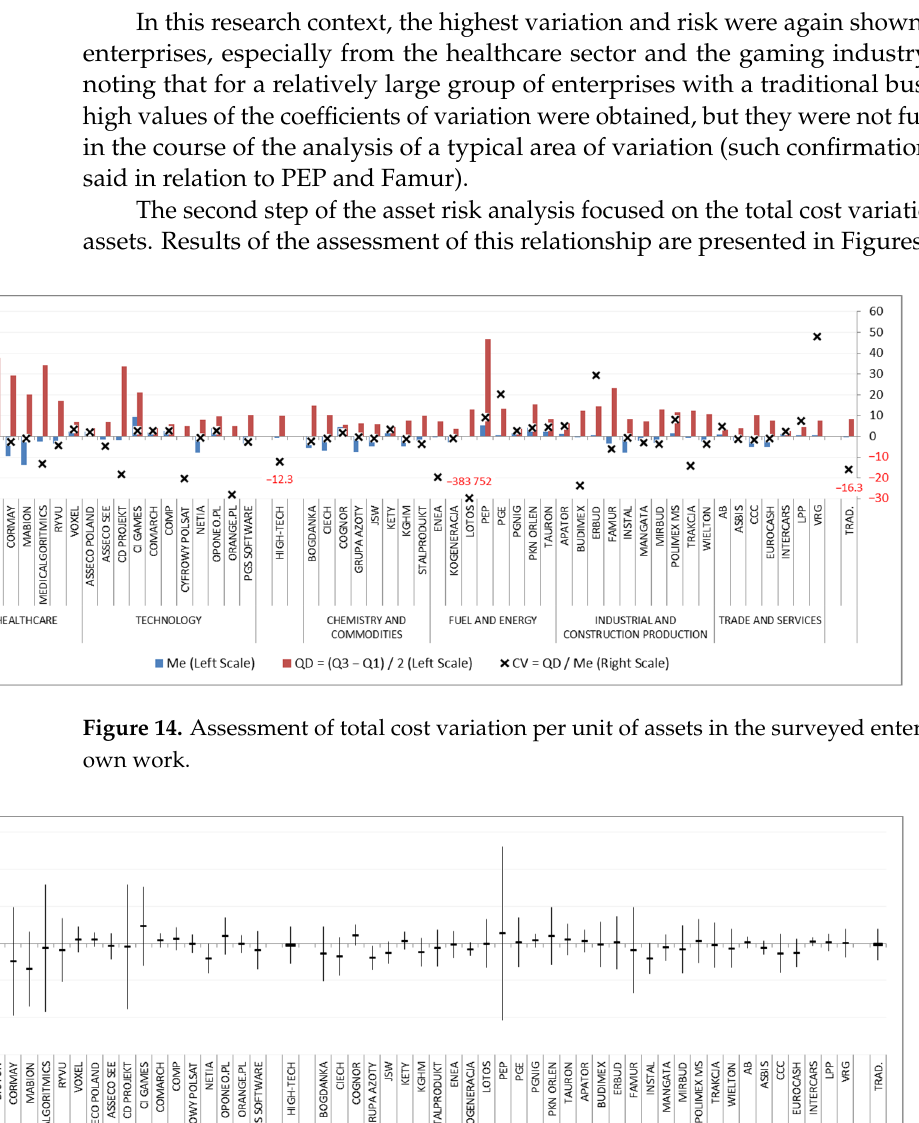
Figure 13. A typical area of variation in asset productivity in the surveyed enterprises. Source: own work.